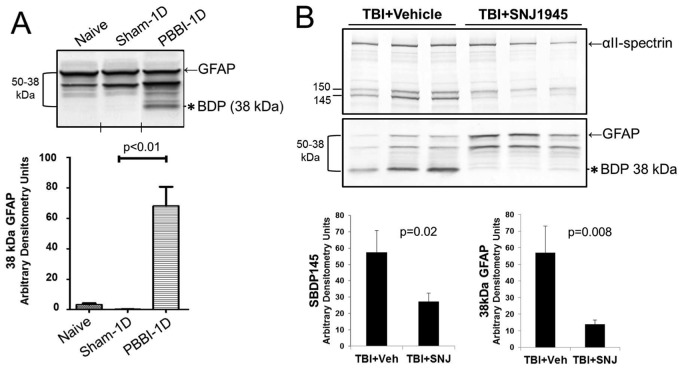
Calpain-associated GFAP breakdown to 38 kDa occurred in vivo.
A. Rats experienced penetrating ballistic-like brain injury (PBBI). Control (naïve, sham) or PBBI brain lysates at 1 day (1D) after injury were immunoblotted and probed with GFAP antibody (Banyan). The 38 kDa GFAP bands were quantified by densitometry. This band was significantly increased compared to controls post PBBI (mean ± SEM; n = 5 per group). Vertical hash marks indicate where intervening lanes were removed. B. Rats were injured by controlled cortical impact (CCI), and injected either with vehicle (n = 3) or the calpain inhibitor SNJ1945 (n = 5). Then brain lysates were immunoblotted and probed with antibodies against αII-spectrin (Enzo) or GFAP (Banyan). Quantification of the SBDP145 and 38 kDa GFAP bands showed that SNJ1945 significantly inhibited formation of SBDP145 and 38 kDa GFAP (mean ± SEM). An asterisk marks the 38 kDa GFAP band throughout.